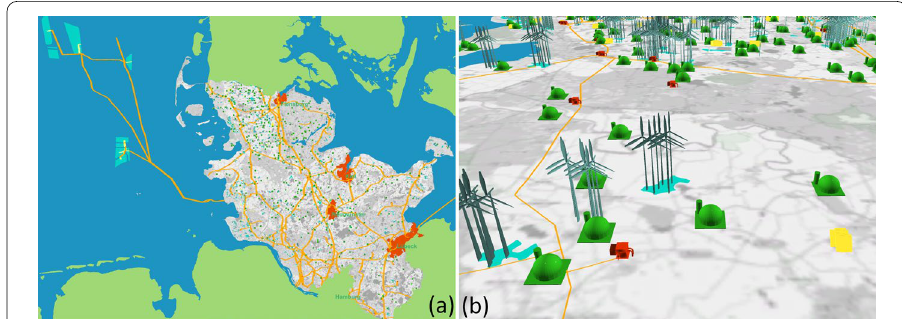
Fig. 1 a Overview of the state of Schleswig-Holstein, displaying representations of the locations of solar parks (yellow), biogas plants (green), wind parks (blue), transformer stations (red), and power lines (orange) on a high-resolution monochrome map. b Detailed isometric view of the region near Hennstett and the river Eider, displaying 3D models for biogas plants (green), wind turbines within wind parks (blue), transformer stations (red), and solar parks